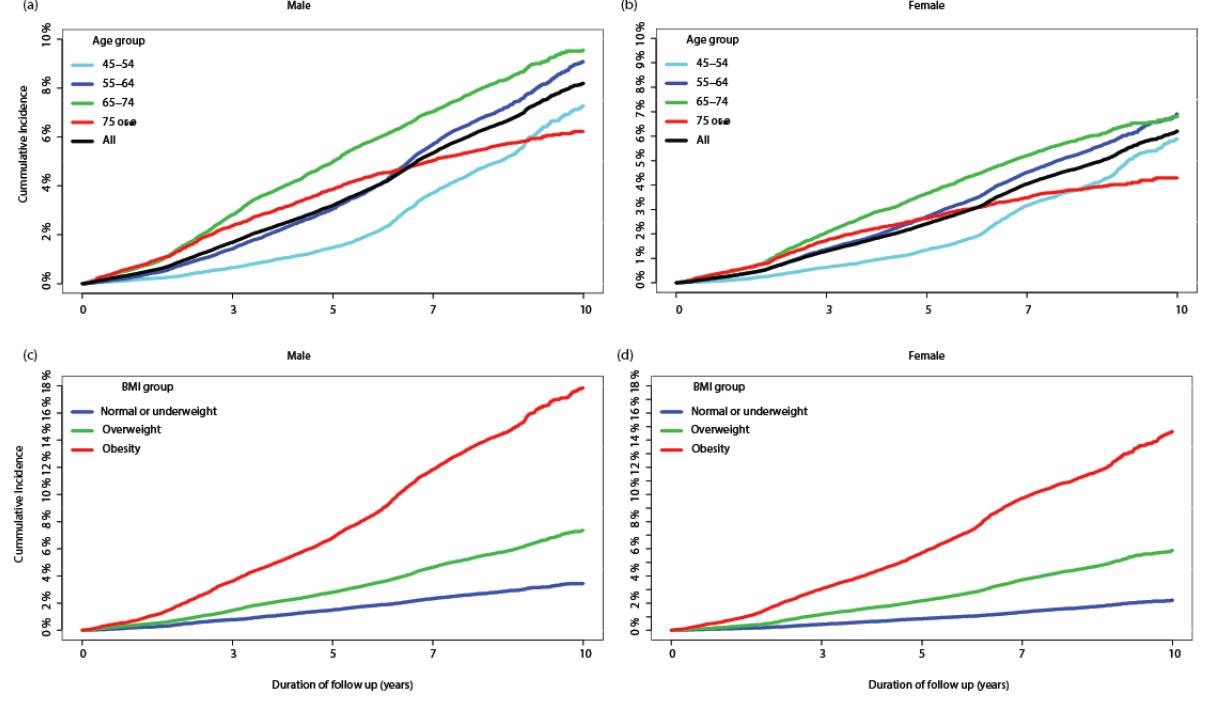
Figure 1. Cumulative incidence of diabetes, stratified by age groups in men and women, and stratified by BMI groups in men and